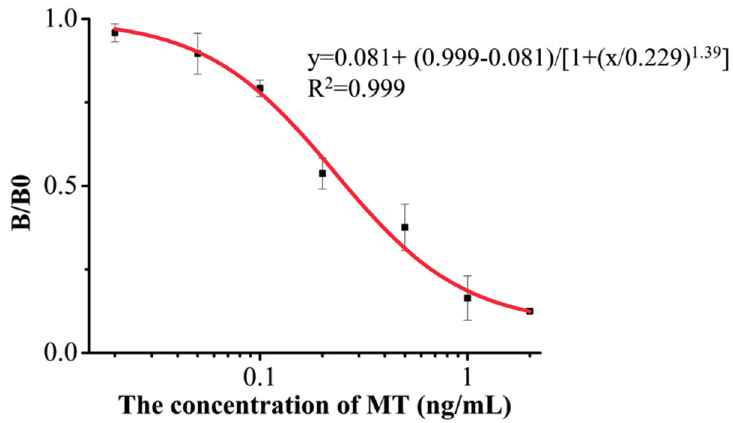
Figure 2. Optimized inhibition standard curve for MT analysis by icELISA. Error bar was calculated according to three repeats at each concentration.